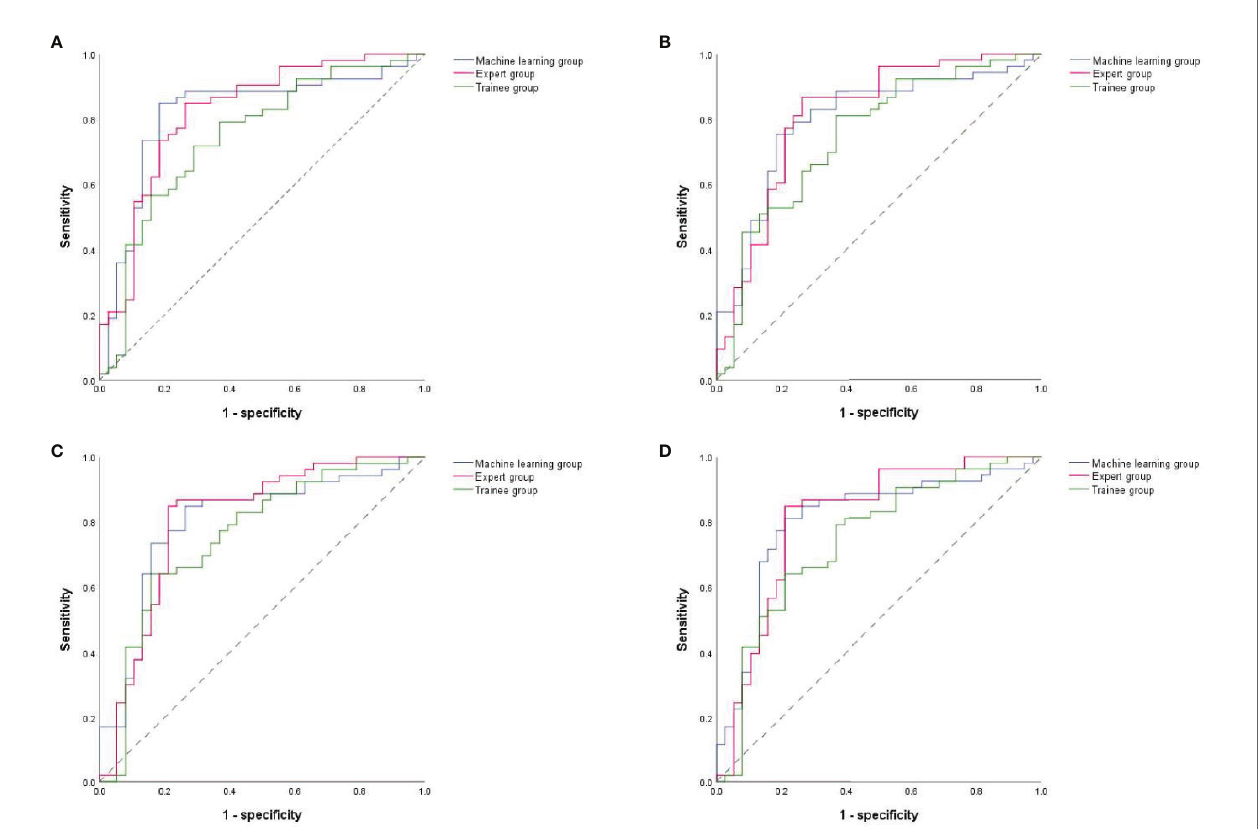
FIGURE 4 | ROC curves of four quantitative methods for machine learning, expert and trainee groups. (A – D) illustrate four quantitative indicators including SAR, B/ G, mean hue value and mean gray value, respectively. ROC, receiver operating characteristic; SAR, stiff area ratio; B/G, elasticity ratio of blue/green.